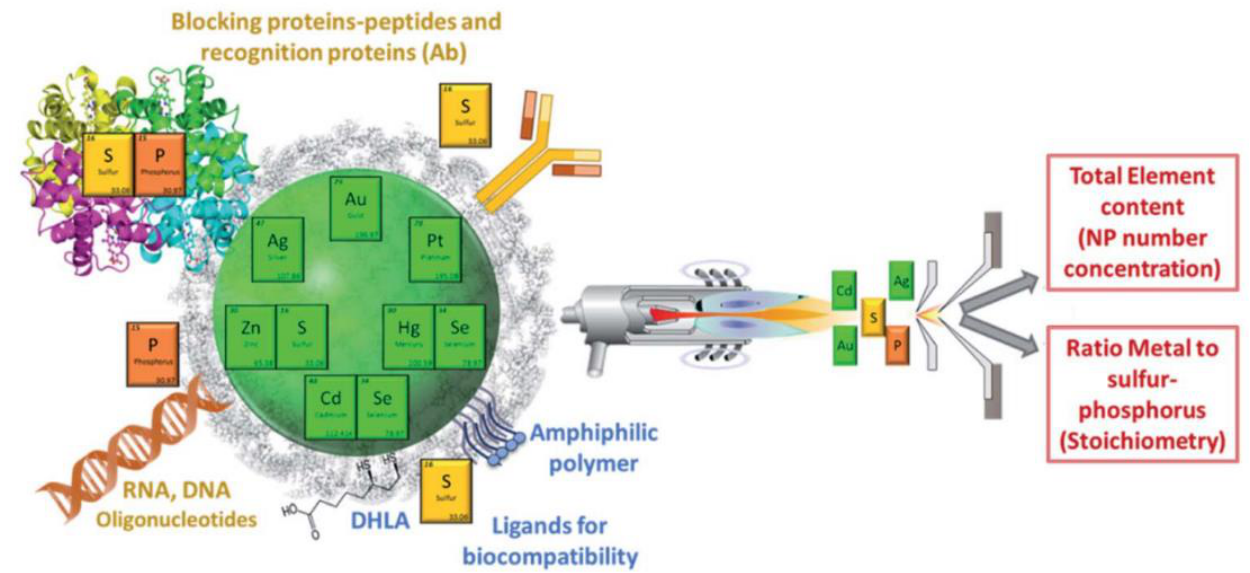
Figure 4. Use of ICP-MS for the characterization of nanoparticles. Reproduced from ref [27] with permission from the Royal Society of Chemistry.